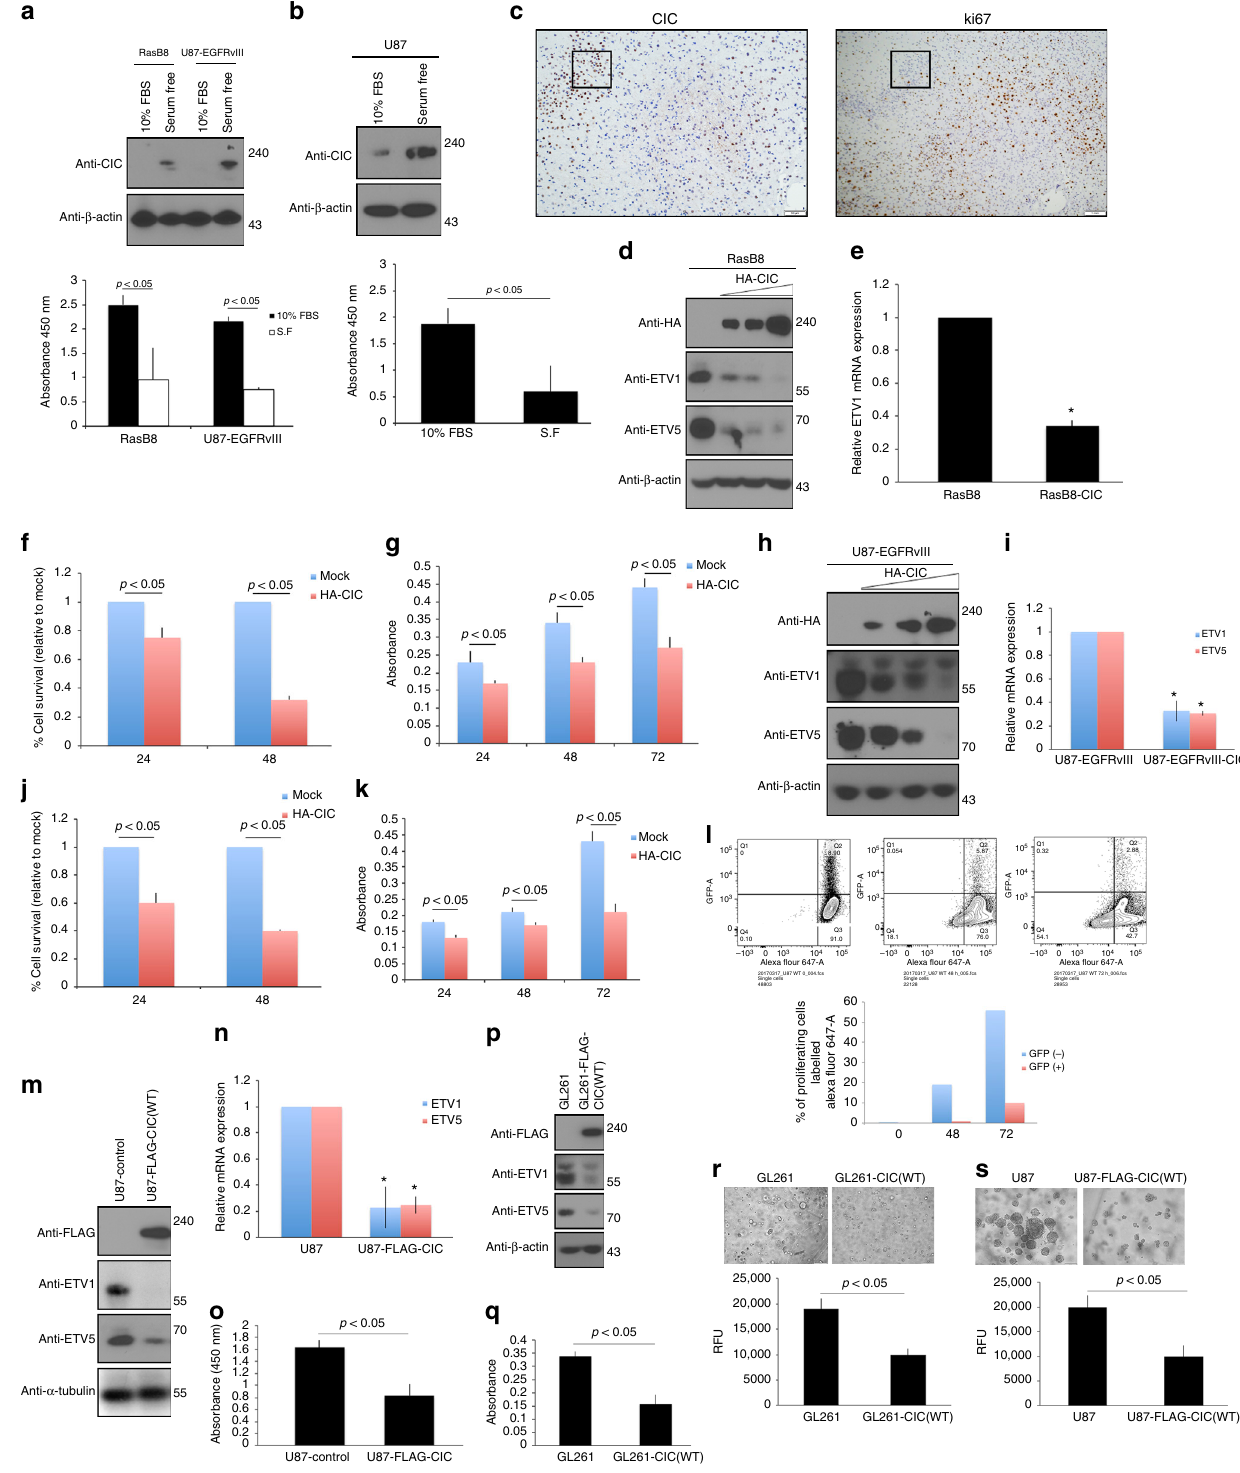
overexpression resulted in loss of nuclear expression of CIC in HEK293 co-transfected cells (Fig. 3r), which was abolished by pre-treatment with either PD98509 or proteasomal inhibitor MG132 (Supplementary Figure 3Q), suggesting that ERK sti- mulates the release of CIC from DNA to initiate ubiquitylation and subsequent degradation of CIC within the nucleus. 3L-P). this fi nding, ERK